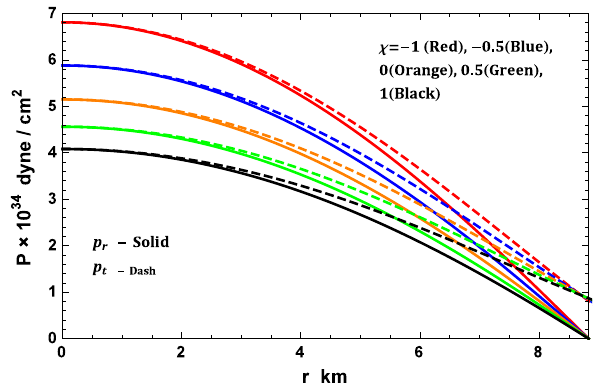
Fig. 5 Equation of state parameter profiles of SMC X-4 for M = 1 . 29 M (cid:9) , R = 8 . 831 km and b = 0 . 0031km −